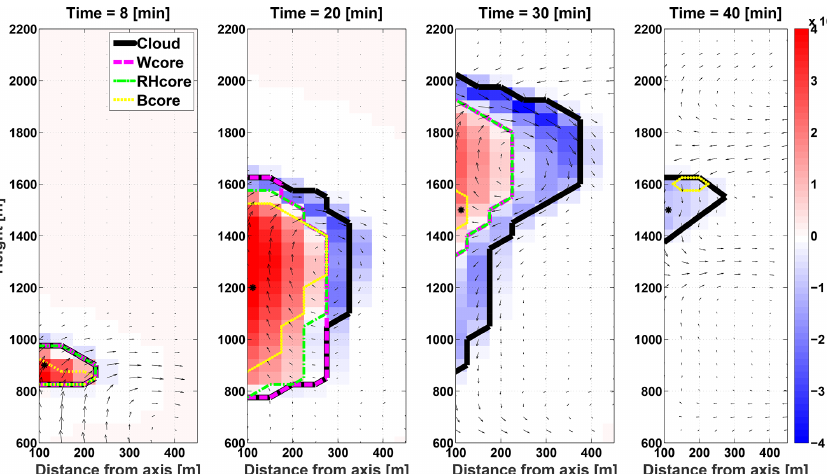
Figure 2. Four vertical cross-sections (at t = 8, 20, 30, and 40min) during the single cloud simulation. y axis represents height (m), and x axis represents the distance from the axis (m). The black, magenta, green, and yellow lines represent the cloud, W core , RH core , and B core , respectively. The black arrows represent the wind, the background represents the condensation (red) and evaporation rate (blue; gkg − 1 s − 1 ), and the black asterisks indicate the vertical location of the cloud centroid. Note that in some cases the lines indicating core boundaries overlap (mainly seen for RH and W cores).